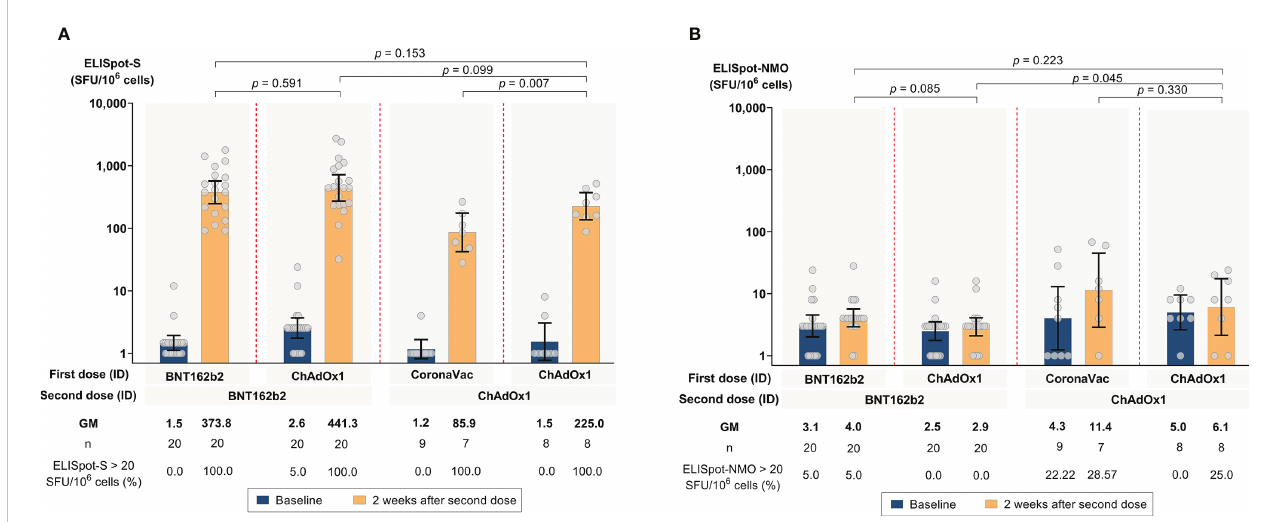
FIGURE 3 SARS-CoV-2 antigen-speci fi c T-cell responses by ELISpot at baseline and 2 weeks after the second dose following accelerated regimens of fractional, ID administration. (A) Spike (S) protein pool-speci fi c T-cell responses. (B) Nucleocapsid-membrane-open (NMO) reading frame protein pool- speci fi c T-cell responses. Error bars represent geometric mean concentrations (GMCs) and 95% con fi dence intervals